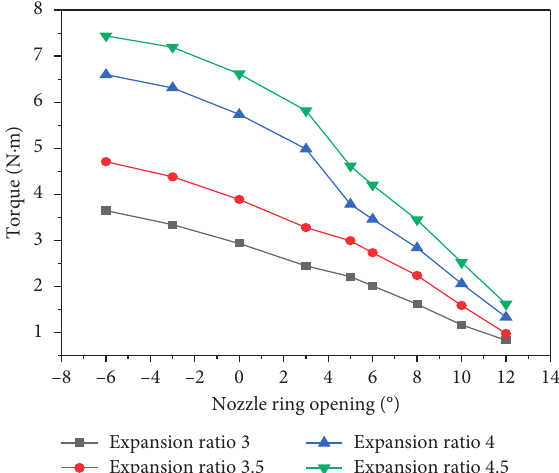
Figure 29: Opening − 6 ° .